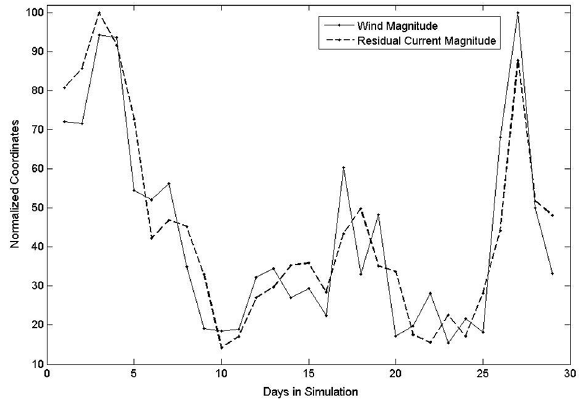
Figure 8. Wind magnitude and lagoon-averaged residual current magnitudes over the duration of the simulation. Both data series are shown using normalized coordinates. The time series are shown averaged over intervals of 25.82 hours (O 1 principal lunar diurnal tidal component